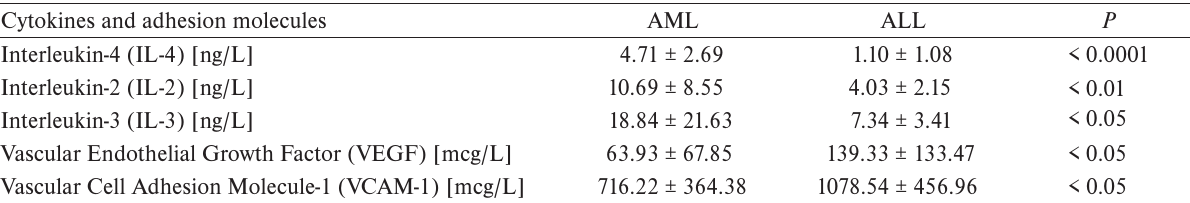
Table 1. Serum levels of selected cytokines and adhesion molecules in patients with newly diagnosed acute myeloid leukemia (AML) and acute lymphoblastic leukemia (ALL). Cytokines and adhesion molecules AML ALL P Interleukin-4 (IL-4)